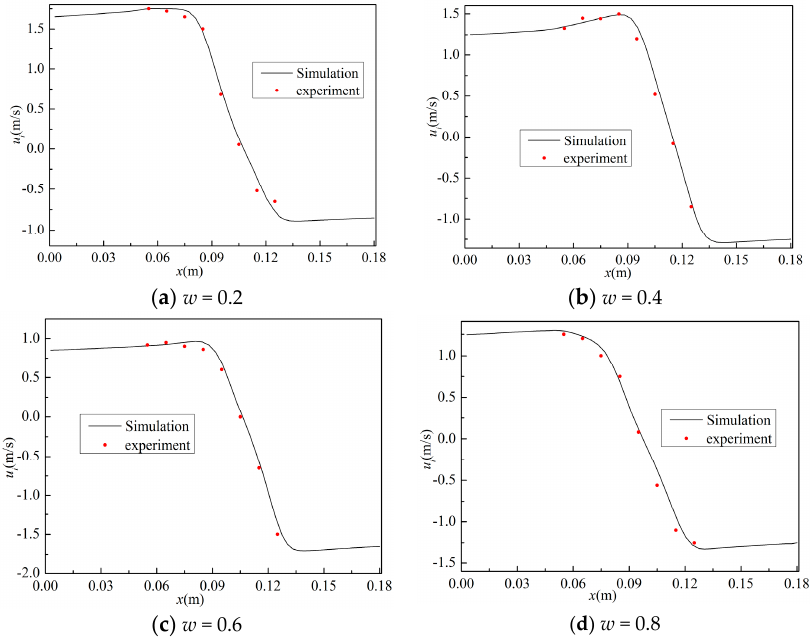
Figure 11. Instantaneous axial velocity distribution on the axis of the nozzle in the xz plane, as determined by PIV and CFD for a sinusoidal inlet velocity at u m = 1.25 m/s, T = 0.4, A = 0.25 m/s, L / D = 4 and ∆ ϕ = T /2 in one